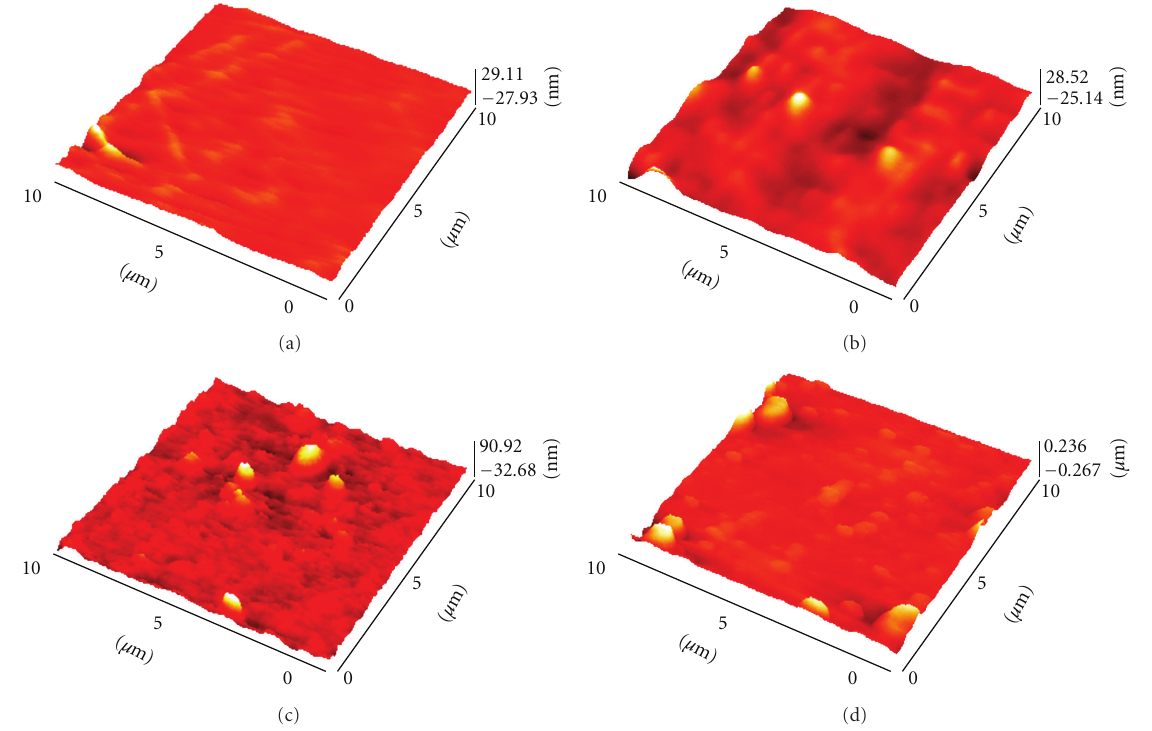
Figure 6: AFM image of (a) untreated (b) 3min treated (c) 5 min treated and (d) 10 min treated PC films.